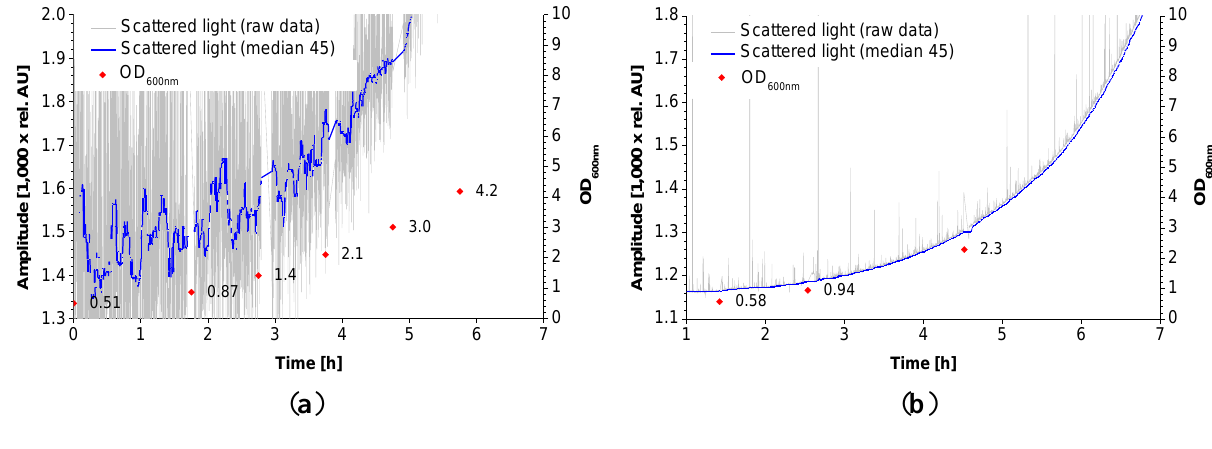
Figure 8. Biomass sensor signal trend during lag-phase and early exponential growth phase of K. pastoris with an unmodified shake flask ( a ) Same cultivation using a custom made light shade within the shake flask ( b